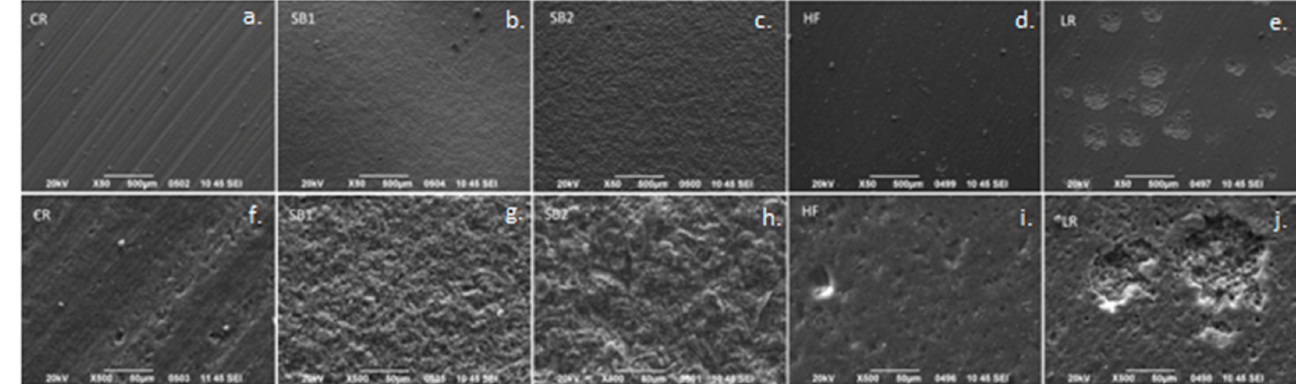
Figure 3. Representative SEM images of the treated surfaces of each experimental group in ×50 (( a – e ) images) and ×500 (( f – j ) images) magnifications. CR: control; SB1: air abrasion with 29 μ m Al 2 O 3 particles; SB2: air abrasion with 53 μ m Al 2 O 3 particles; HF: hydrofluoric acid gel + silane; LR: Er,Cr:YSGG laser treatment.